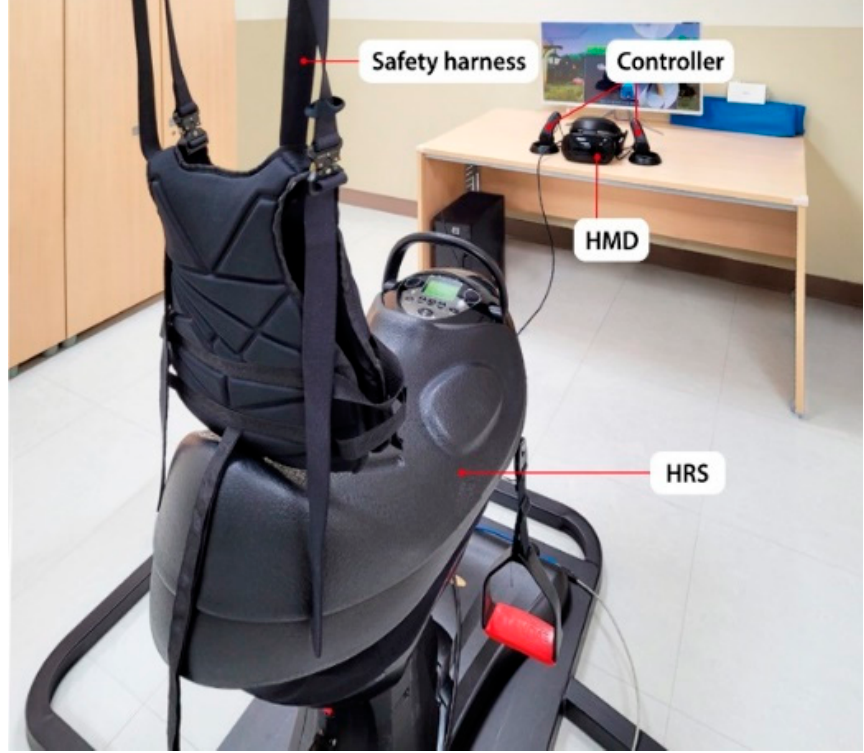
Figure 1. Architecture of the proposed virtual reality (VR)-incorporated horse riding simulator (HRS).